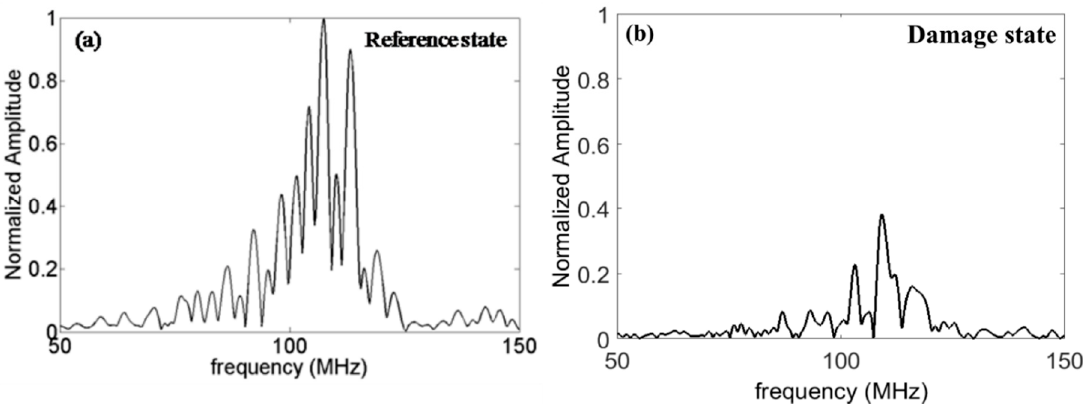
Figure 7. The frequency spectrum of the longitudinal wave ( a ) in reference and ( b ) damaged sensors excited using scanning acoustic microscopy at 100 MHz.